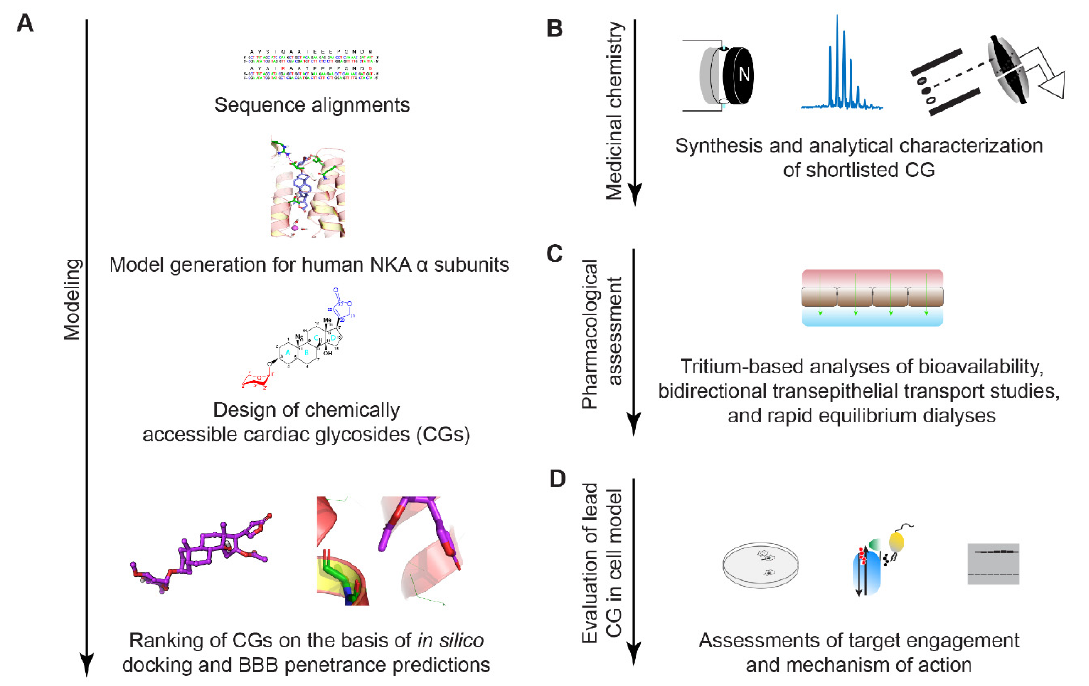
Figure 1. Study design. ( A ) In silico identification of a CG with favorable predicted docking characteristics and BBB barrier penetrance. ( B ) Synthesis and characterization of short-listed CG. ( C ) Assessment of BBB penetrance and distribution in relevant tissue. ( D ) In vitro characterization of potency and mechanism of action for PrP C reduction of lead CG in cell-based assay.